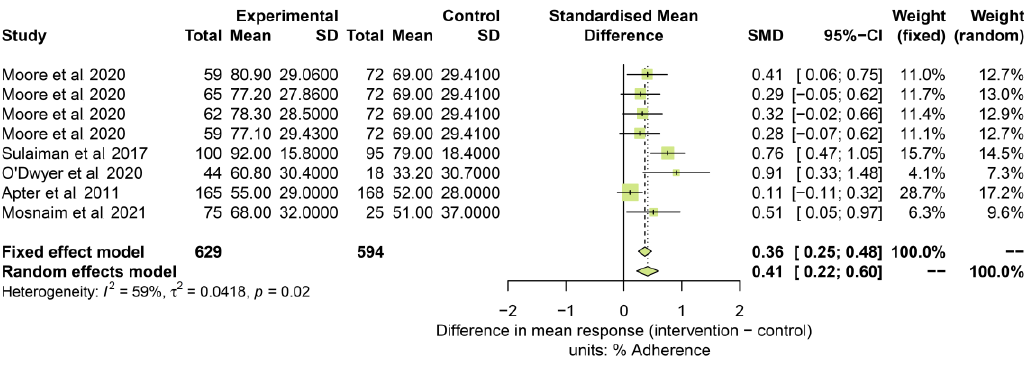
Figure 7. Asthma control test (ACT) outcomes. References: 23, 51. 4. Discussion To the best of our knowledge, this is the first systematic review with meta-analysis exploring the characteristics and assessing the impact of clinical interventions derived from data of EMDs in adult patients with asthma or COPD. The most remarkable result to emerge from our study is the positive impact of EMD-based interventional pro- grammes on adherence to inhaler treatment and the tendency to positive or mixed results in other outcomes such as symptom control, with potential benefits for daily practice in the optimization of inhaled therapy management.